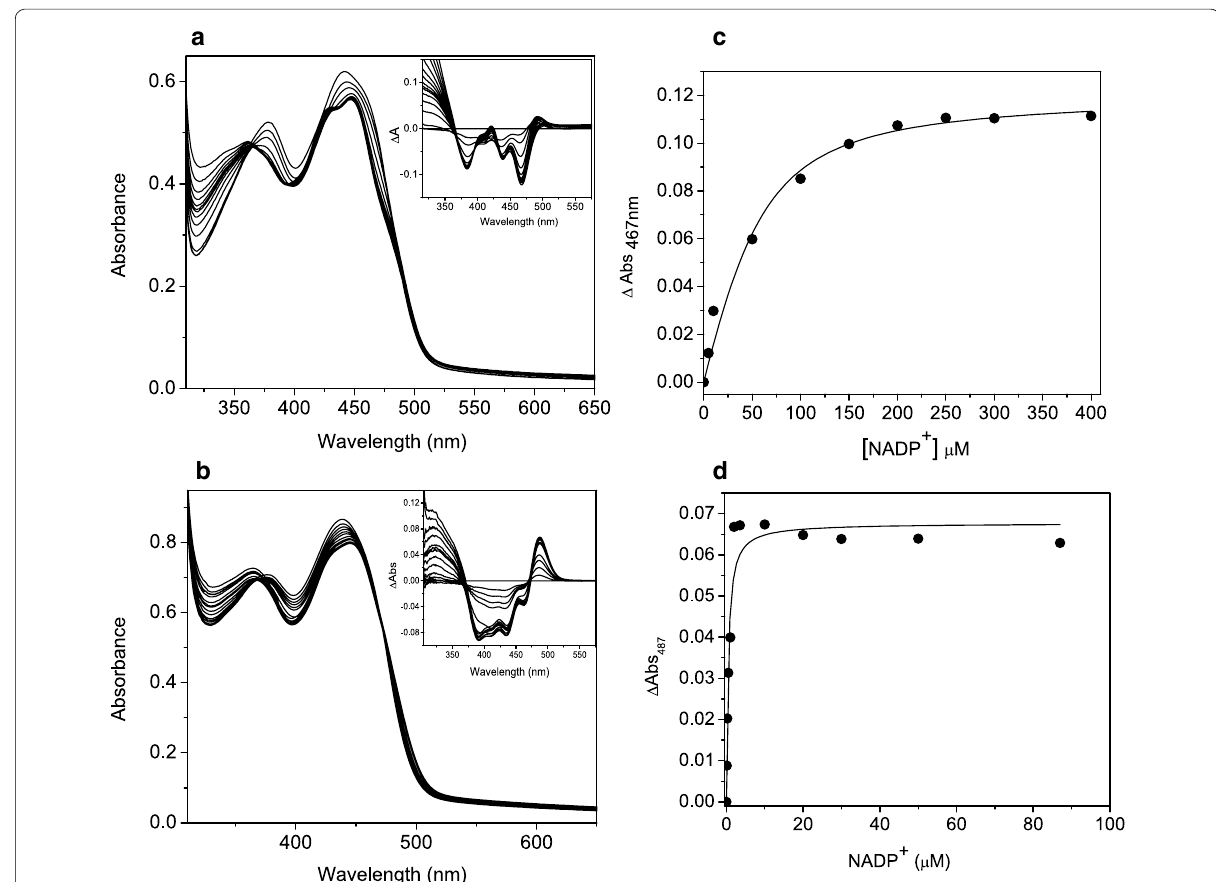
Fig. 3 Flavin absorption spectra of GSTACMO ( a ) and H325K ( b ) were recorded in 50 mM HEPES–NaOH pH 7.5 upon titration with NADP + (0–250 μM). The inset shows the difference spectra. Absorbance changes at 467 nm for wild type GSTACMO ( c ) and H325K ( d ) were plotted as a function of NADP + concentration and the data were fitted to a quadratic binding isotherm (Eq. 1), which gave K d values of 21.1 and 0.50